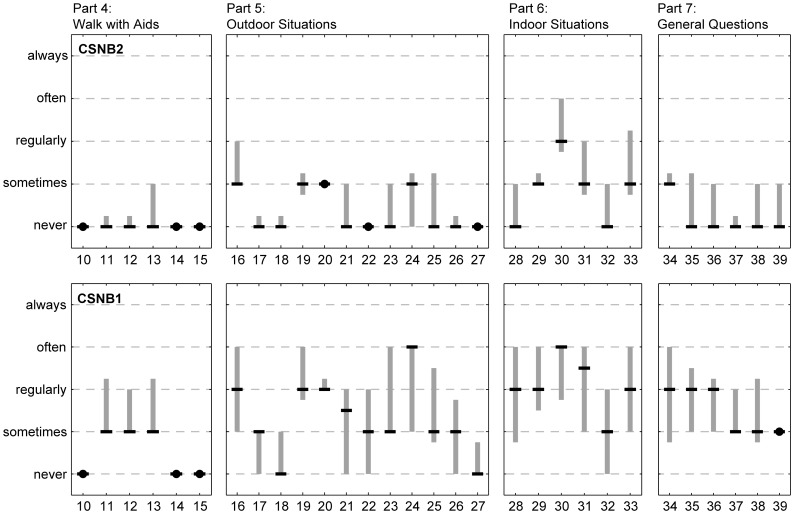
Results of Parts 4 to 7 of the questionnaire.Top: answers of CSNB2 patients. Bottom: answers of CSNB1 patients. The black horizontal lines indicate the medians. The grey vertical lines extend from the first quartile to the third quartile and thus indicate the range of the mid 50% ranked answers. A black dot is used when the mid 50% ranked date contained one answer only.